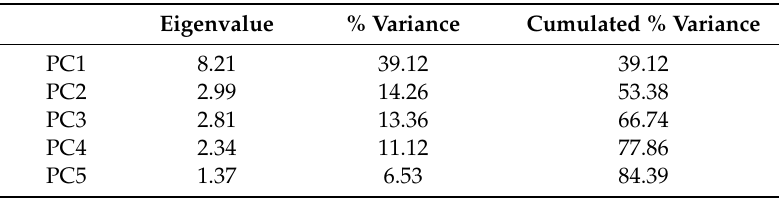
Table 6. Factor loadings of analyzed variables for the first five principal components